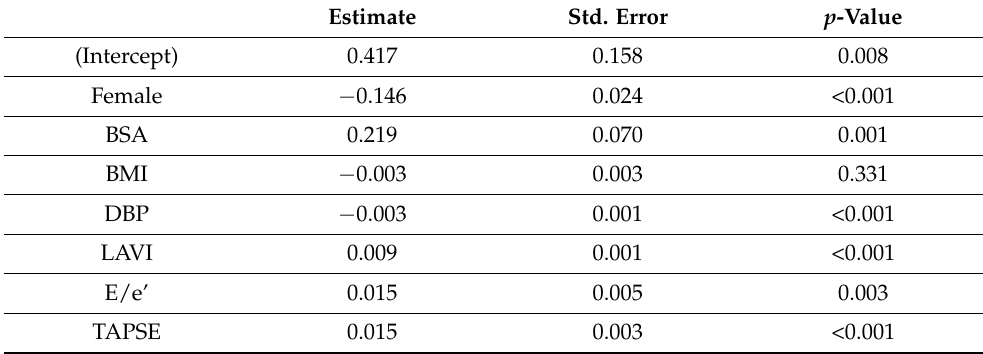
Table 5. Multivariate analysis of THE MEE values. Estimate Std. Error